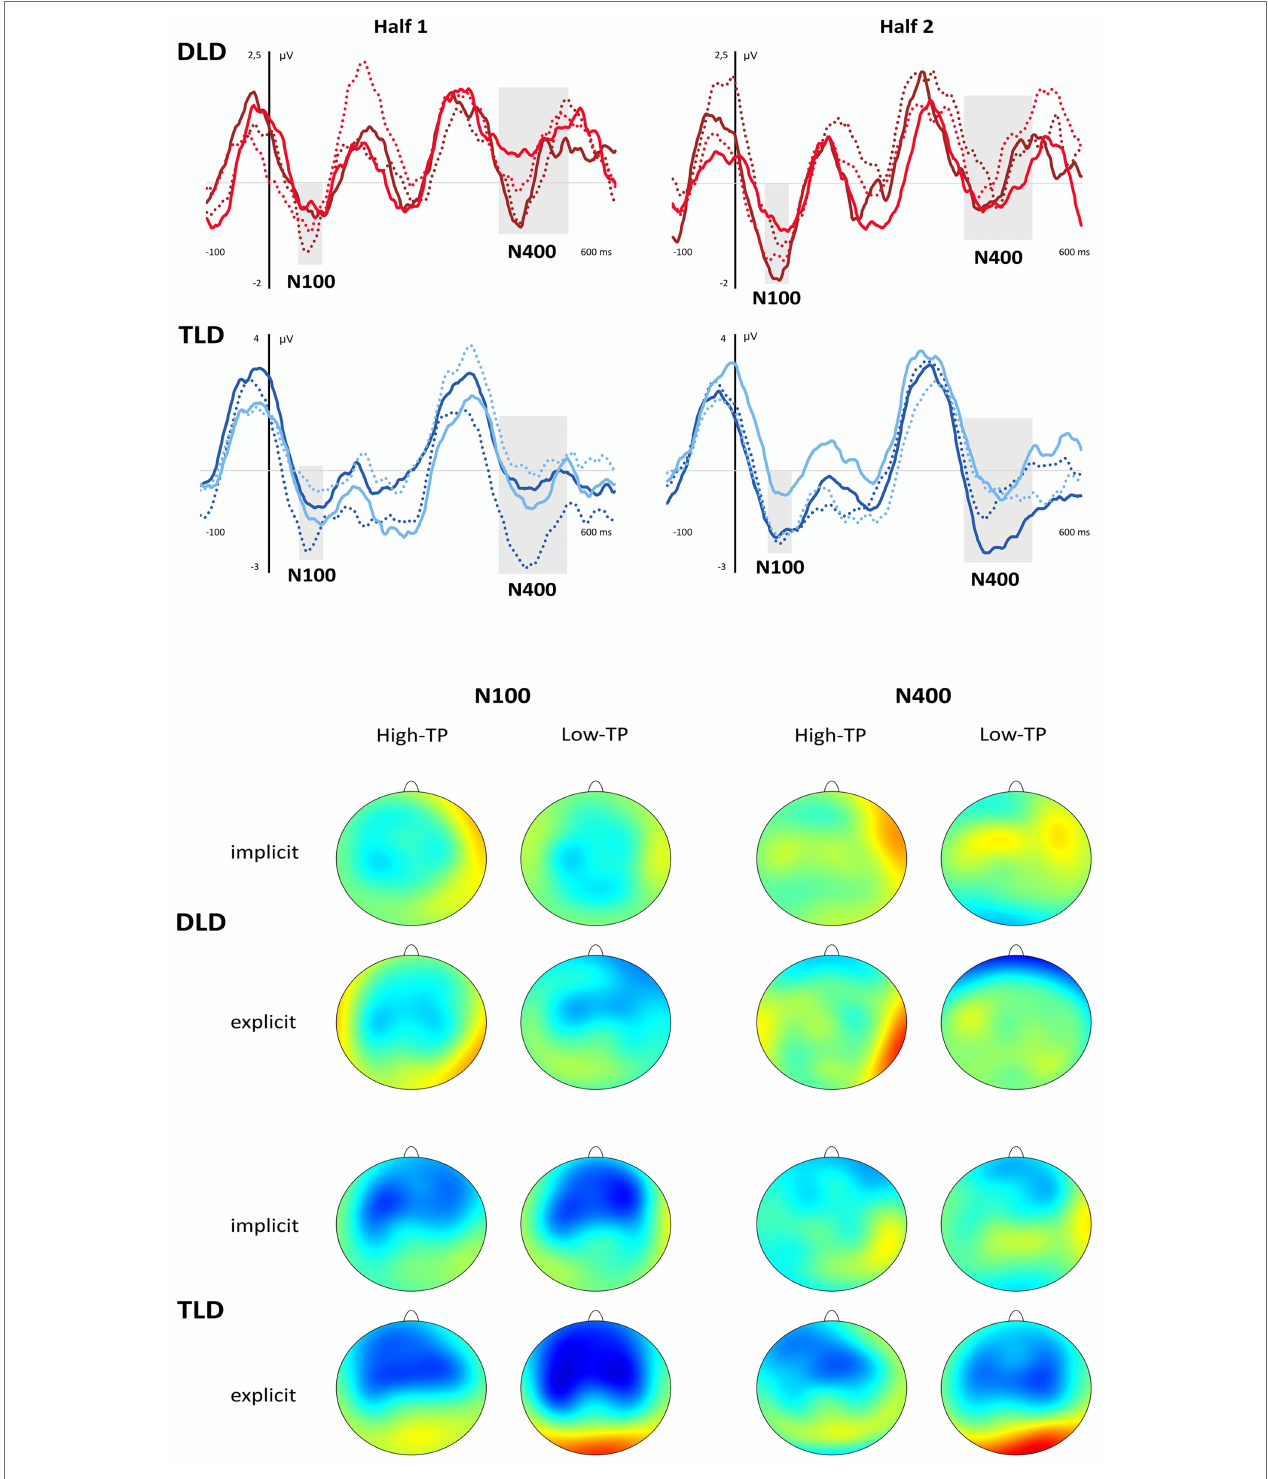
FIGURE 4 | Grand-Averaged Waveforms (Central ROI) and Topographic Maps in the DLD and TLD Groups. In the up panel, the gray shadowed rectangles indicate the analyzed time windows (N100 and N400). DLD, developmental language disorder group: Light red solid line = implicit high-TP condition; Light red dotted line = implicit low-TP condition; Dark red solid line = explicit high-TP condition; Dark red dotted line = explicit low-TP condition. TLD: typical language development group: Light blue solid line = implicit high-TP condition; Light blue dotted line = implicit low-TP condition; Dark blue solid line = explicit high-TP condition; and Dark blue dotted line = explicit low-TP condition. In the bottom panel, values of the topographical images range from − 3 to 3 μ V in each group and